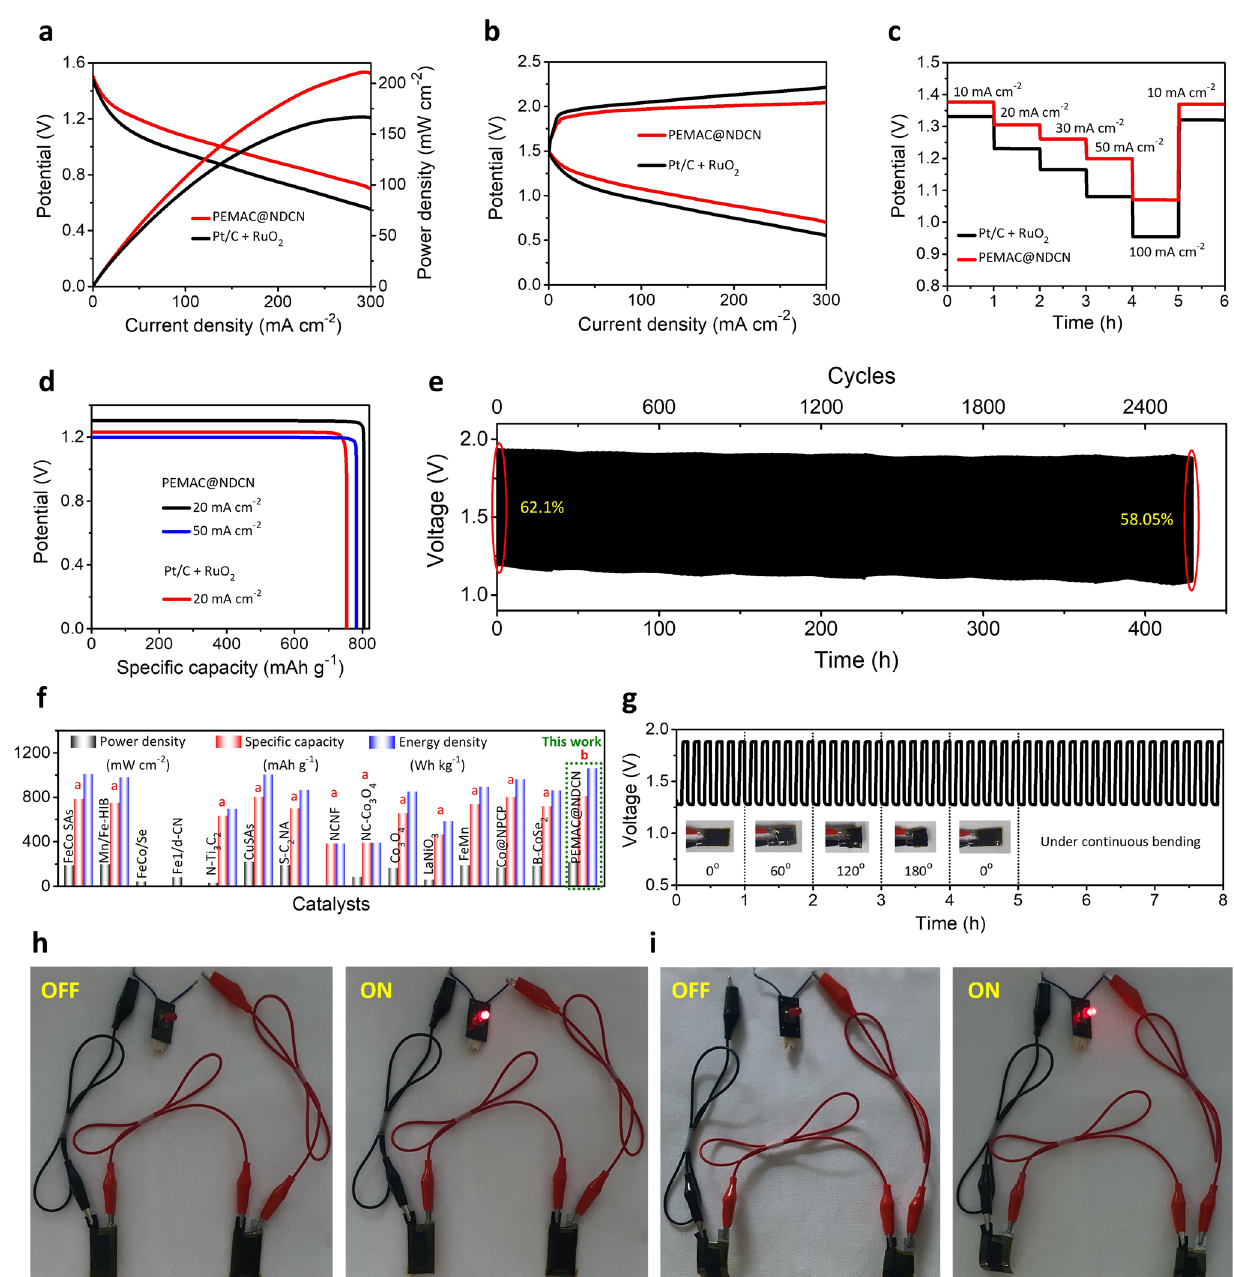
Fig. 9 Electrochemical performances for flexible ZABs. a Power densities and galvanostatic discharge voltage polarizations for PEMAC@ NDCN // CBCs // Zn compared to those of reference Pt/C + RuO 2 // CBCs // Zn cells. b Discharge and charge measurements for PEMAC@ NDCN relative to Pt/C + RuO 2 reference materials. c Rate capacity measurements for PEMAC@NDCN // CBCs // Zn relative to those of refer‑ ence Pt/C + RuO 2 // CBCs // Zn cells from 10 to 100 mA cm −2 . d Calculated capacities and energy densities for PEMAC@NDCN // CBCs // Zn and Pt/C + RuO 2 // CBCs // Zn cells. e Cycle life assessments for PEMAC@NDCN // CBCs // Zn cells for the current rate of 50 mA cm −2 (Time: 10 min per cycle). Note that the stated percent values are the voltaic efficiencies. f Ragone plot illustrates the projections over cell capaci‑ ties and energy densities of designed PEMAC@NDCN // CBCs // Zn cells in comparison with previously reported champion ZABs. Note that the “a” defines the current density in the range of 1–5 mA cm −2 and “b” represents the current density in the range of 25–50 mA cm −2 . g Dis‑ charge–charge mechanical bent testing (0, 60, 120, and 180°) and with continuous bent over 60° of PEMAC@NDCN // CBCs // Zn cells for 25 mA cm −2 . Inset shows the practical pictures of ZABs. h Powering of red LED using two ZABs in series under planar conditions. i Powering of red LED using two ZABs in series under bent condition. (Conditions: cathode‑PEMAC punched on carbon cloth, electrolyte‑CBCs 1 , and anode‑Zn